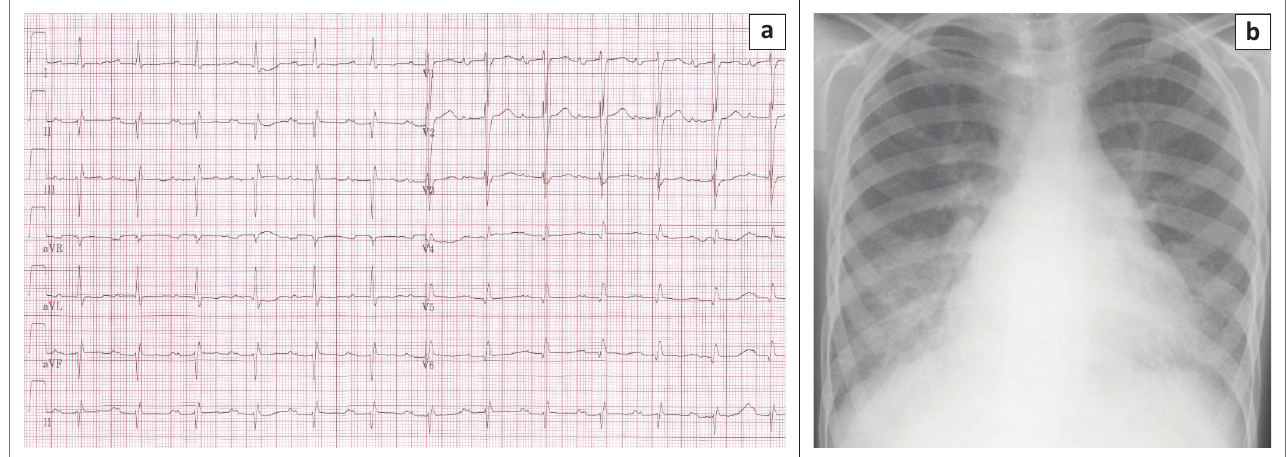
FIGURE 3: Electrocardiogram (3a) and chest X-ray